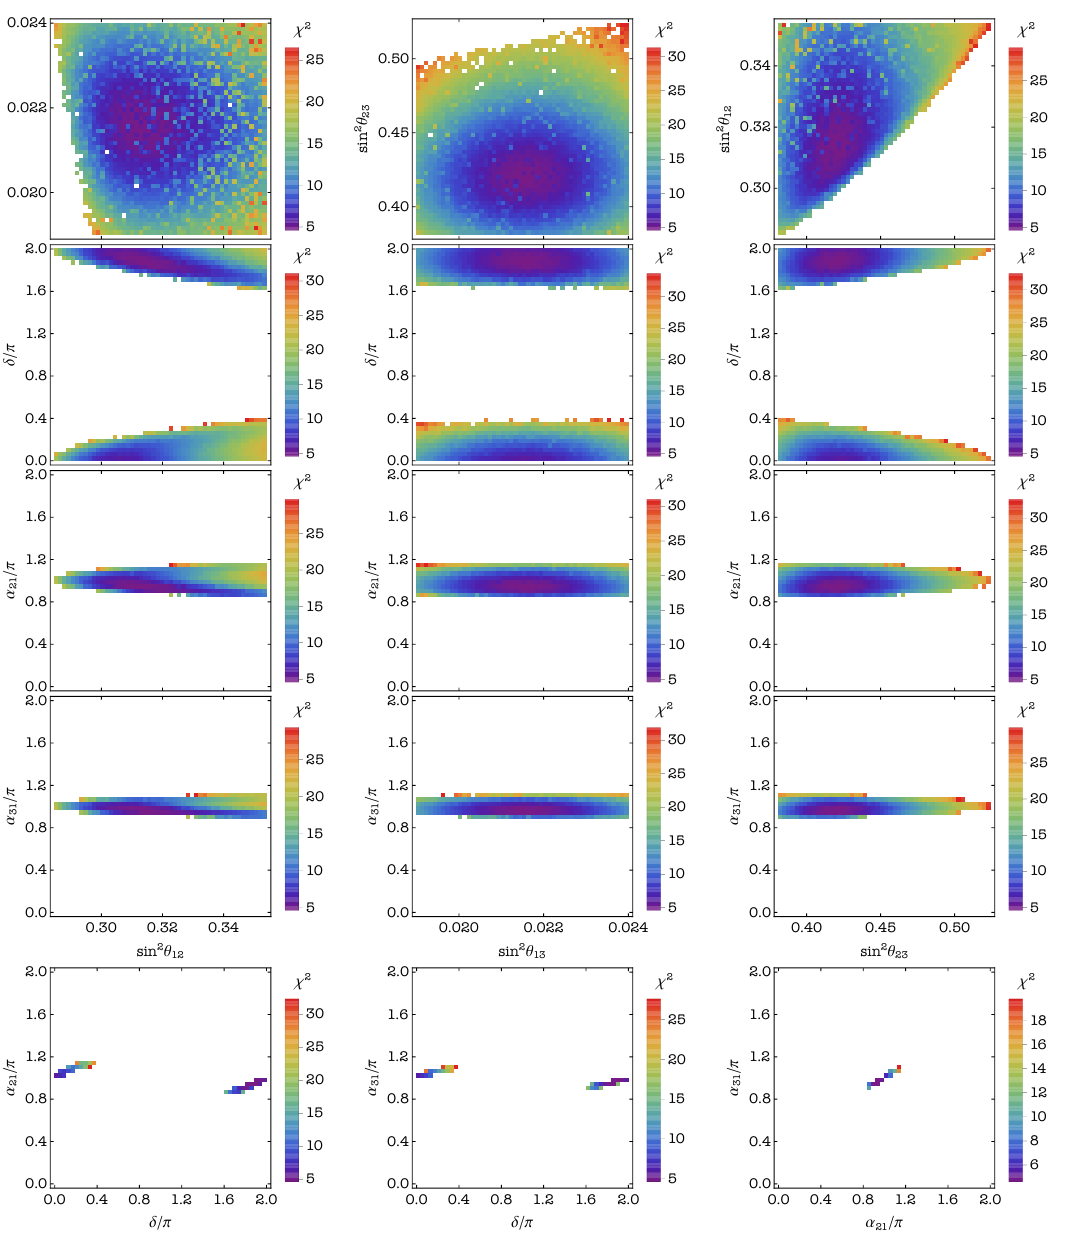
Figure 6 . Correlations between the neutrino mixing parameters in case C2. The values of all the three mixing angles are required to lie in their respective 3 (cid:27) ranges. Colour represents values of (cid:31) 2 for the NO neutrino mass spectrum.